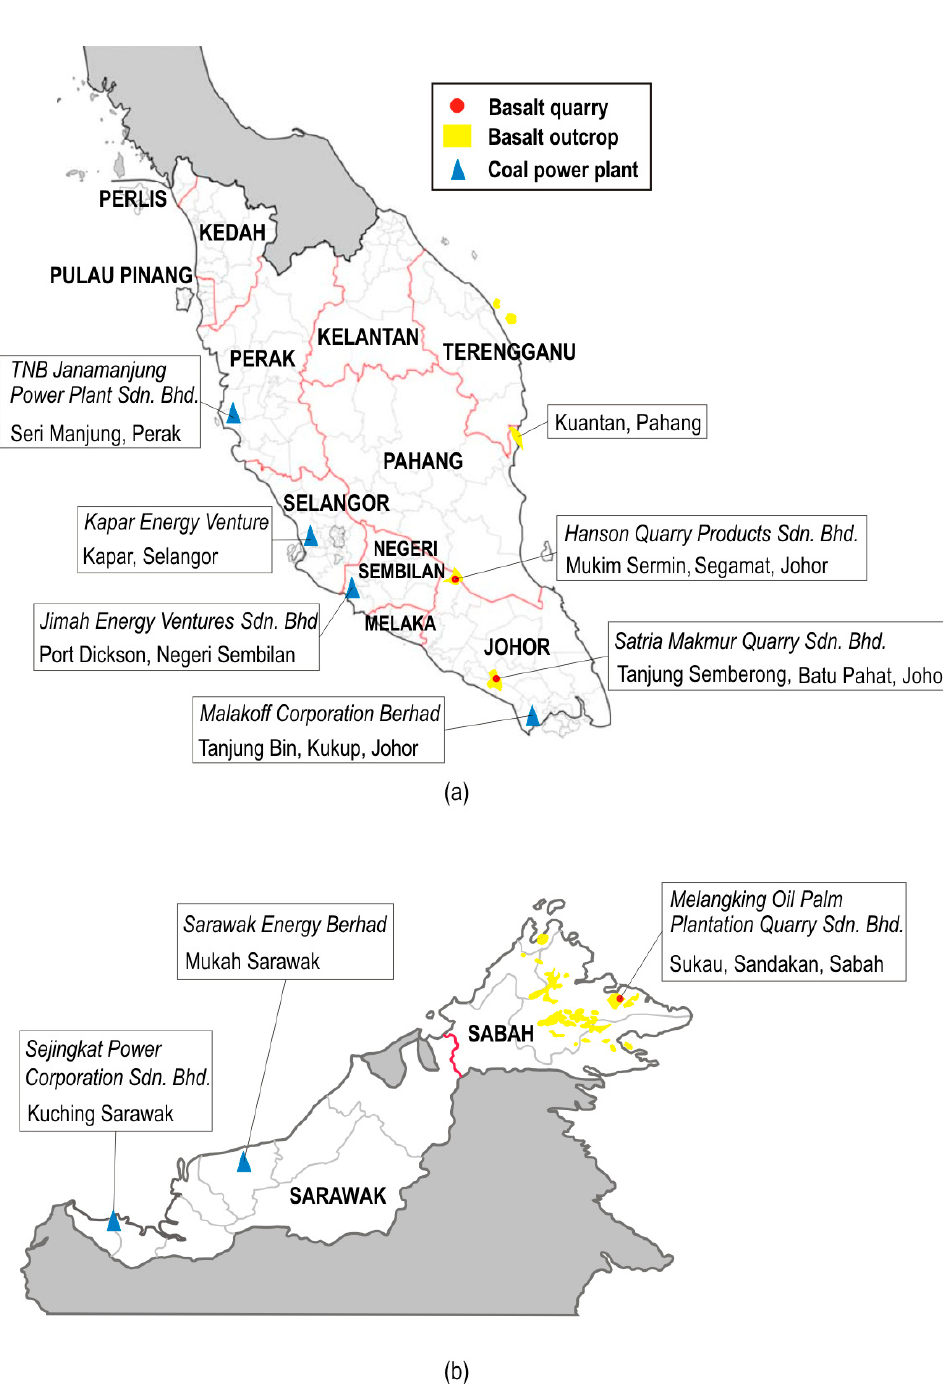
Figure 2. Map of ( a ) Peninsular Malaysia (adopted from https://openclipart.org/detail/290360/peninsular-malaysia-blank-map) and ( b ) East Malaysia showing locations for basalt quarry, basalt outcrop, and coal power plant. Information regarding basalt quarries and outcrops was derived from Department of Mineral and Geoscience Malaysia [71] and, regarding coal power plants, was derived from https://endcoal.org/global-coal-plant-tracker/.